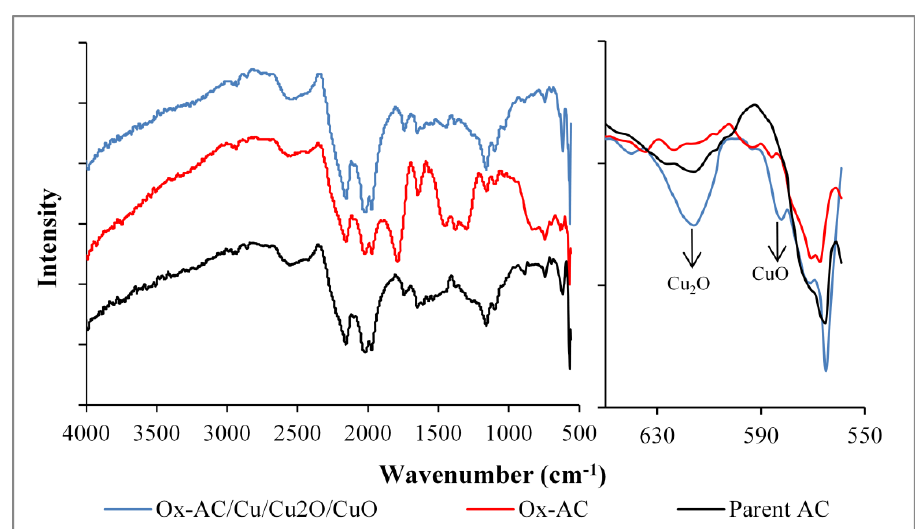
Figure 5. FTIR spectra of parent AC, Ox-AC, and Ox-AC/Cu/Cu 2 O/CuO.